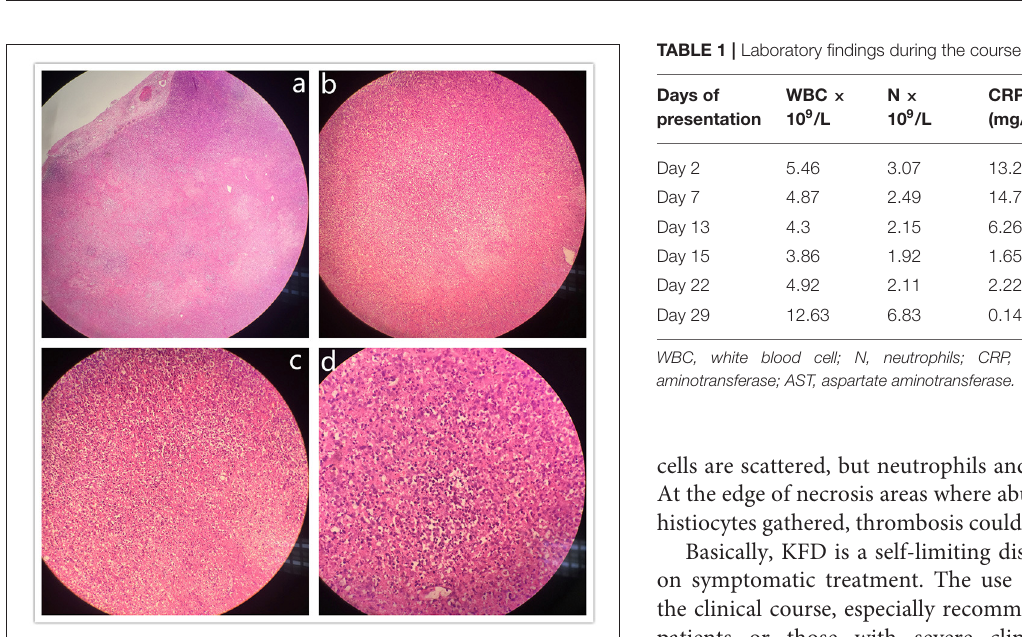
FIGURE 2 | Histopathological findings of lymph node biopsy. Lymph node sections showed partially preserved lymphoid architecture with lymphoid follicles and paracortical coagulative necrosis with karyorrhectic debris and apoptosis, absence of neutrophils, and presence of histiocytes and lymphoid cells. (H&E stain; (a) original magnification × 40; (b) , original magnification × 100; (c) , original magnification × 200; (d) , original magnification × 400).